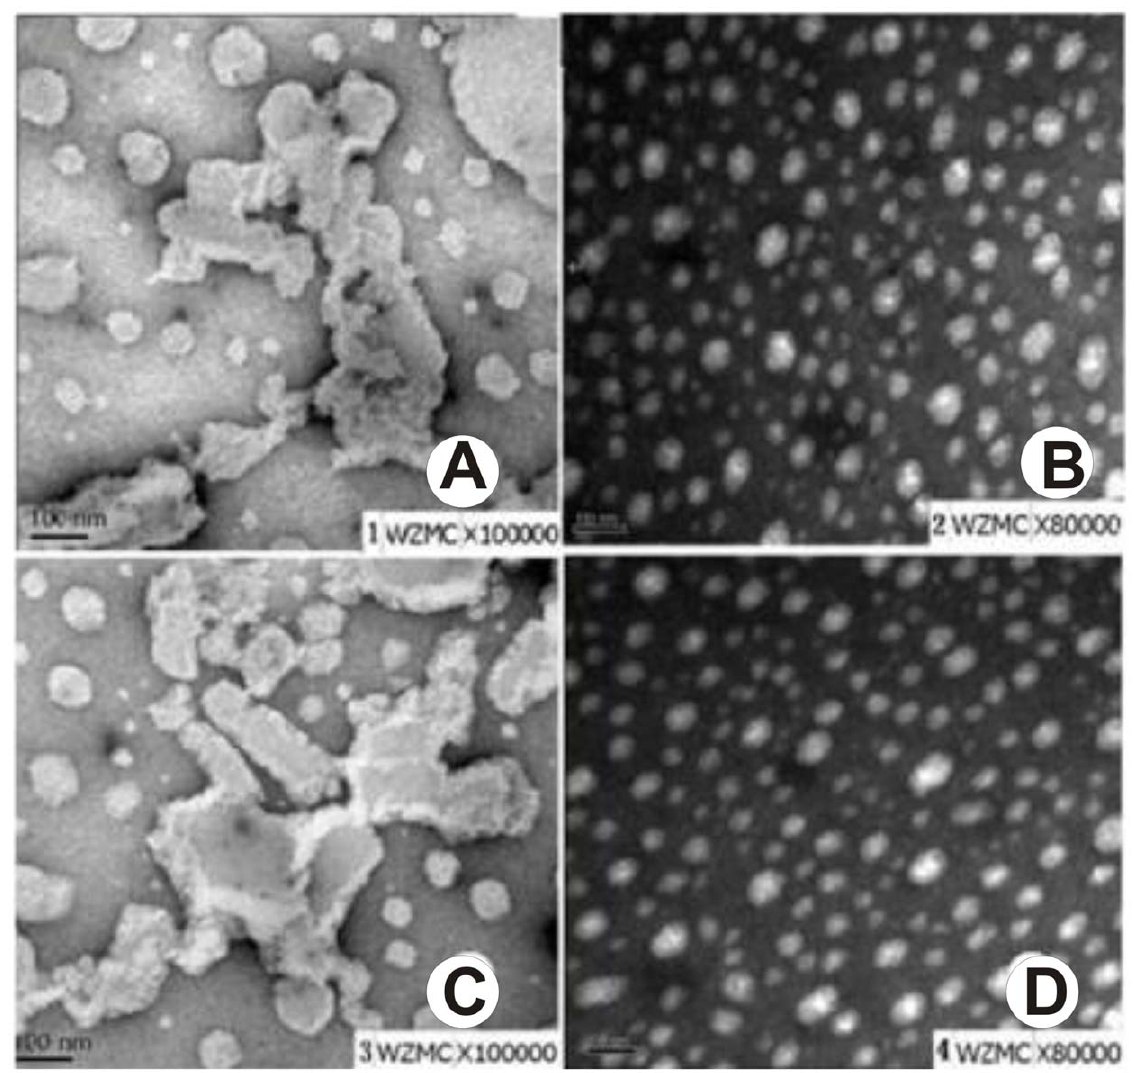
Figure 3. Negative-stained TEM images. (A) E17F-37/PCDA vesicles with LPS/DMPC/PCDA. (B) E17F-37/PCDA vesicles with DMPC/PCDA. (C) E18R-42/PCDA vesicles with LPS/DMPC/PCDA. (D) E18R-42/PCDA vesicles with DMPC/PCDA. Scale bar is 100